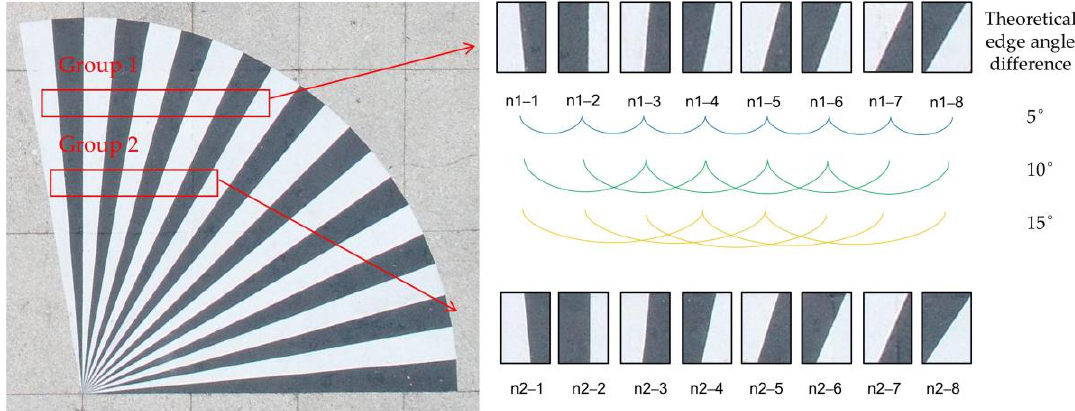
Figure 11. Experimental ROI. Table 3. MSE of experimental results.